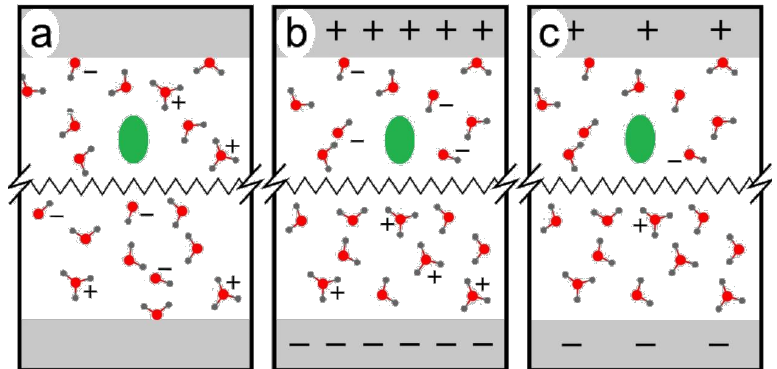
Figure 1. General model: We start our consideration from an aqueous solution containing a pollutant (green). ( a ) The situation before applying a potential is stable. It contains a small amount